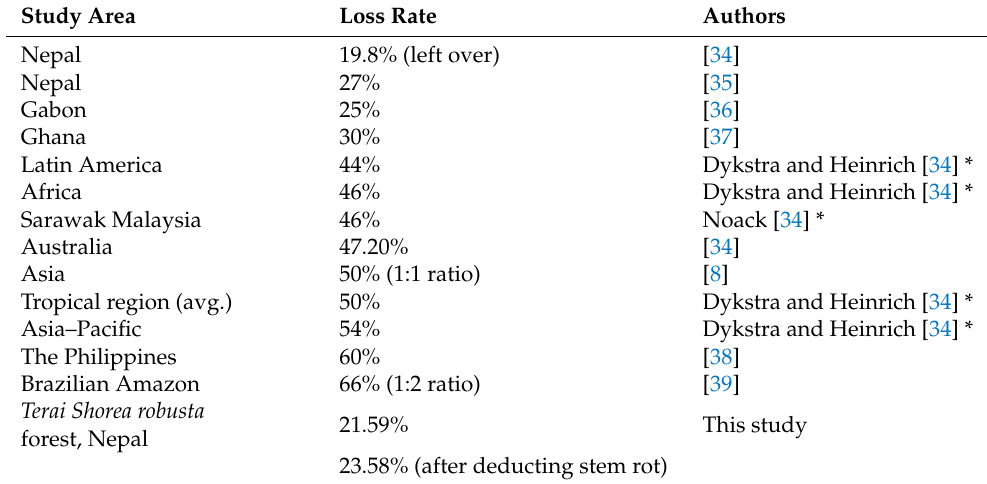
Table 5. Table showing tree harvesting loss rate of previous studies. Study Area Loss Rate Authors Nepal 19.8% (left